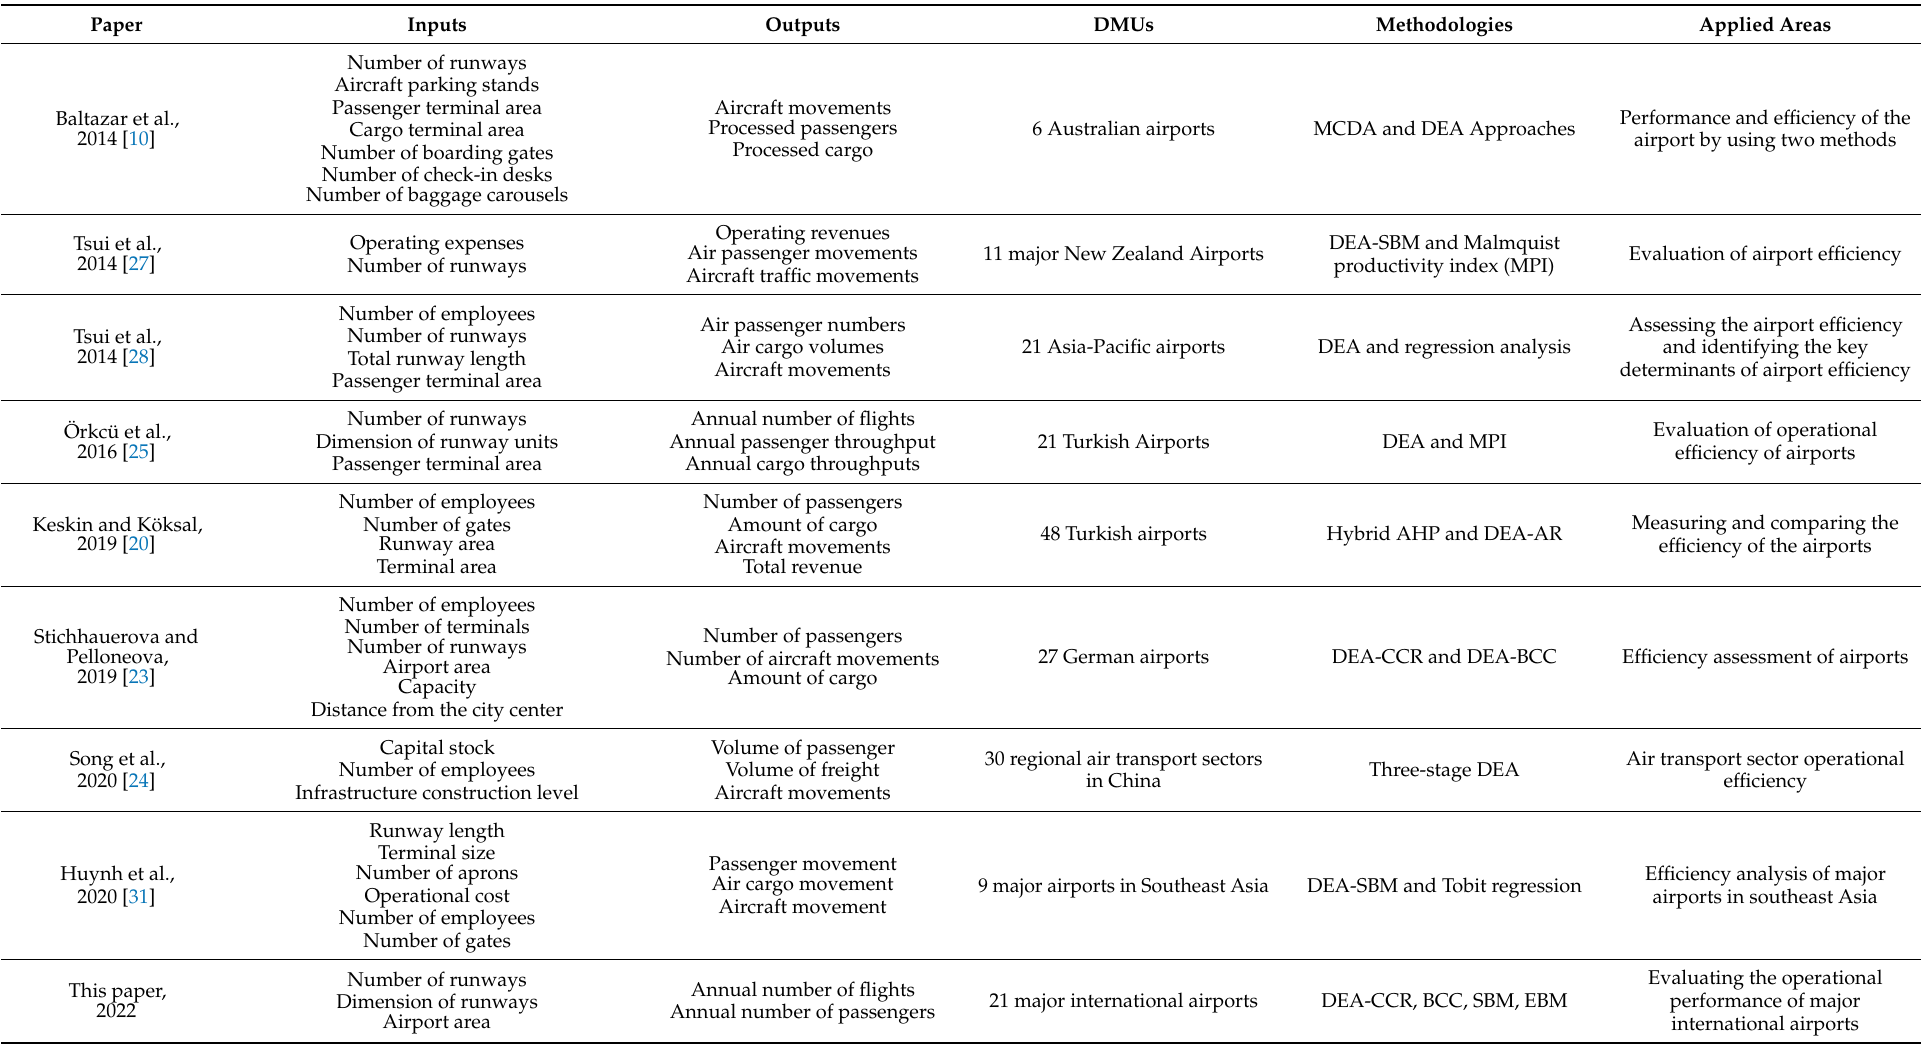
Table 1. Summary of methodologies and problem characteristics in relevant